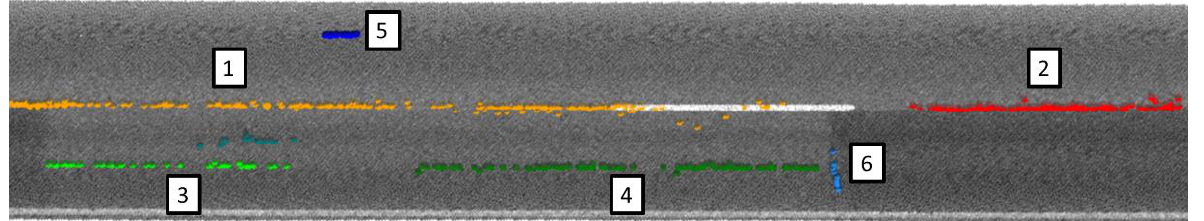
Figure 10. Road spot 1. Crack points detected with the proposed algorithm, grouped in clusters by color.